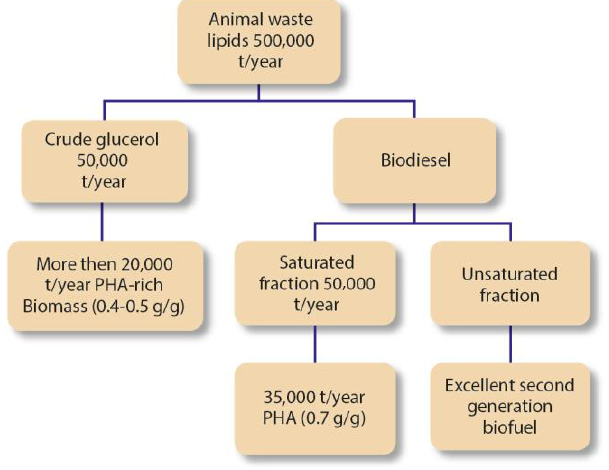
Figure 5. Production flow chart of PHA from waste streams from slaughterhouses. Adapted from “Bioplastics: Development, Possibilities and Difficulties”, Environmental Research, Engineering and Management, vol. 68, no. 2, Jul. 2014, doi: 10.5755/j01.erem.68.2.6777 [32]. PHB is produced by bacteria, algae and genetically modified plants through enzy- matic processes. The process starts with the condensation of two molecules of acetyl-CoA into acetoacetyl-CoA, which is then reduced by acetoacetyl-CoA reductase to produce β - hydroxybutyryl- CoA. PHB is obtained by the polymerization of β -hydroxybutyryl-CoA. To harvest the PHB, it is necessary to destroy the cell, since it is present as cysts within the cytoplasm of the cell [33,39,40].